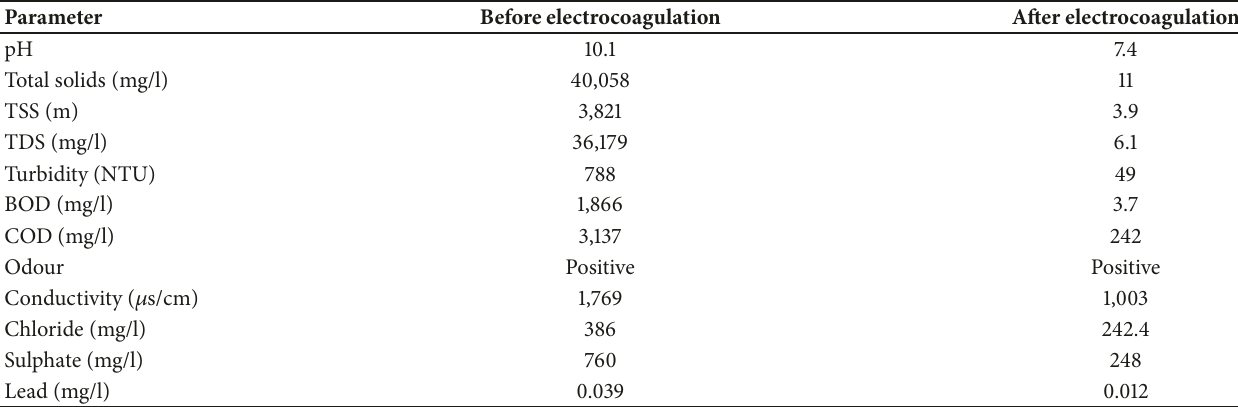
Table 2: Characterization result of PW before electrocoagulation and after electrocoagulation at optimum conditions of 3 Amps, 60min, pH of 2, and 60 ∘